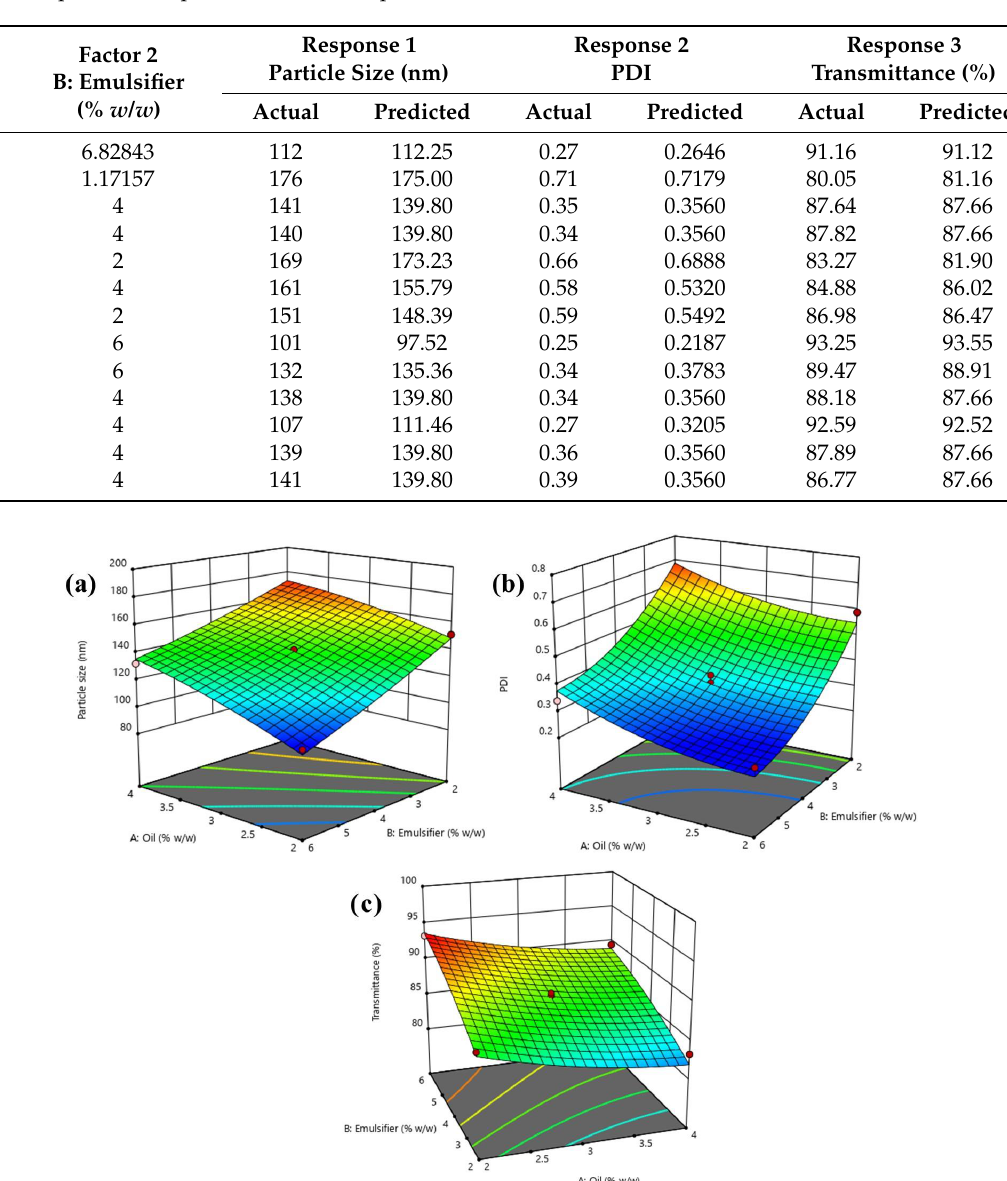
Table 2. Observed CCD experimental runs on lidocaine-loaded nanoemulsion with their actual and predicted experimental value of particle size, PDI and transmittance.